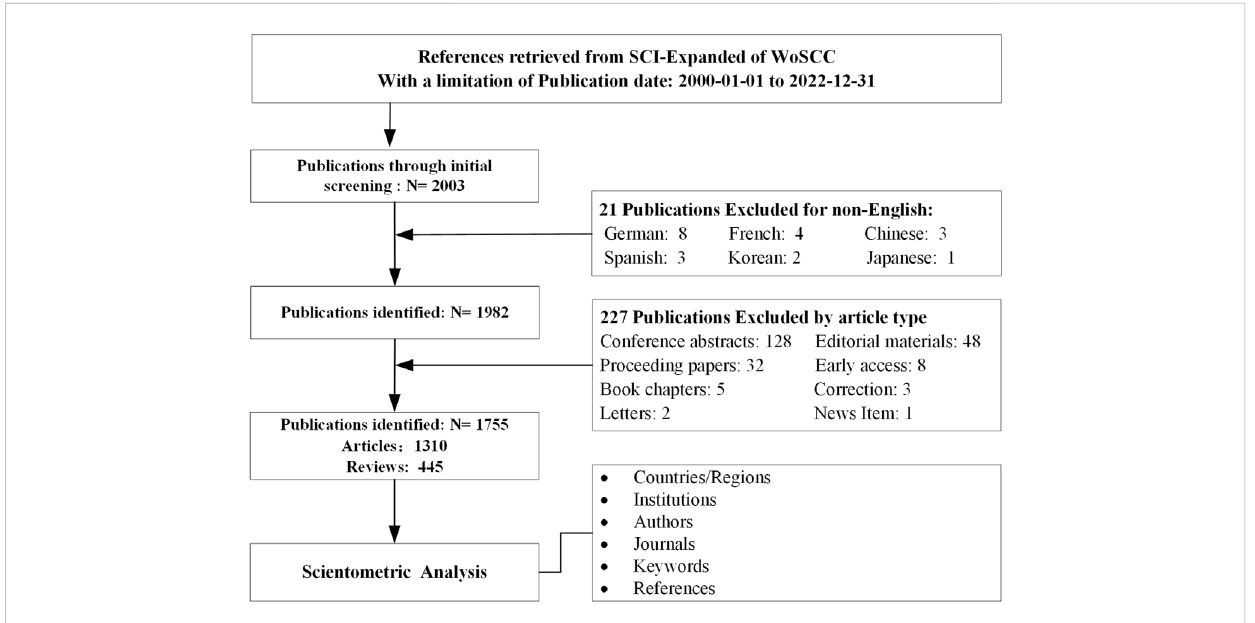
FIGURE 1 Flowchart of the study